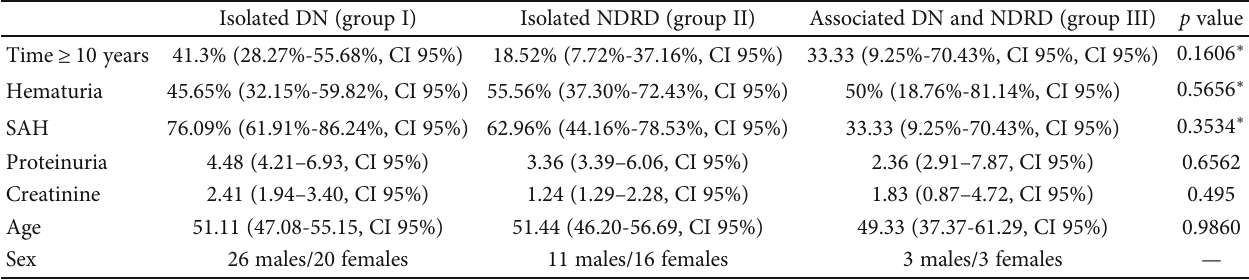
Table 1: Sample description and comparison between groups DN (group I)/isolated NDRD (group II)/associated NDRD and DN (group III).